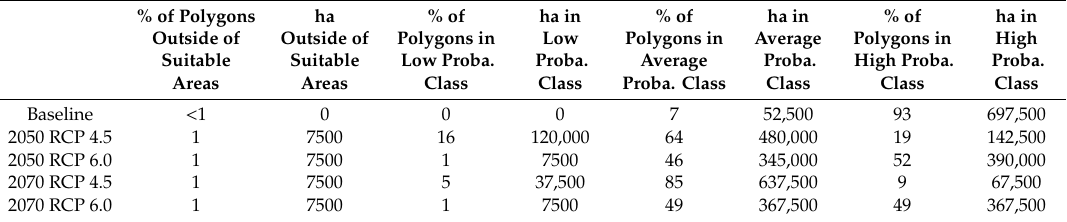
Table 2. Percentage and ha of grapevine crops in the probability classes to find suitable area.